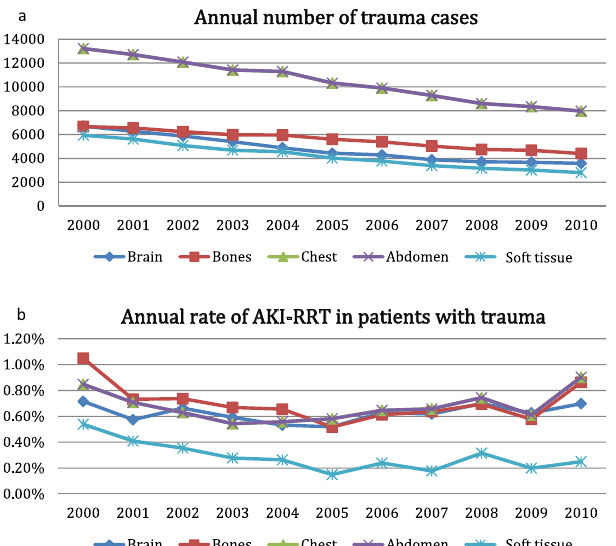
Figure 3. Temporal patterns of annual number of trauma cases ( a ) and annual rate of traumatic AKI-RRT ( b ) stratified by injured body part (annual rate of vehicle-traumatic AKI-RRT = annual number of vehicle-traumatic AKI-RRT/ annual number of trauma cases). ( b ) p for trend, brain: 0.697, bones: 0.186, chest: 0.484, abdomen: 0.484, Skin: